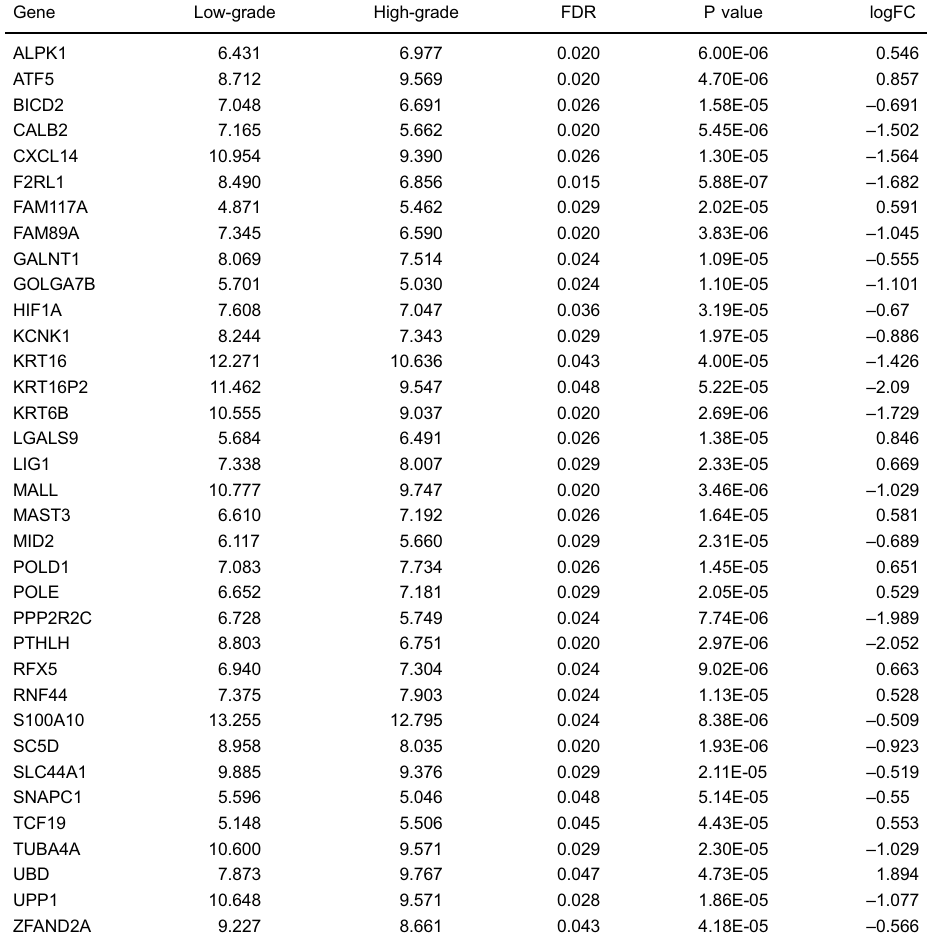
Table 1. Signi fi cantly differential genes (SDGs) expression levels in low- and high-grade head and neck cancer tissues.